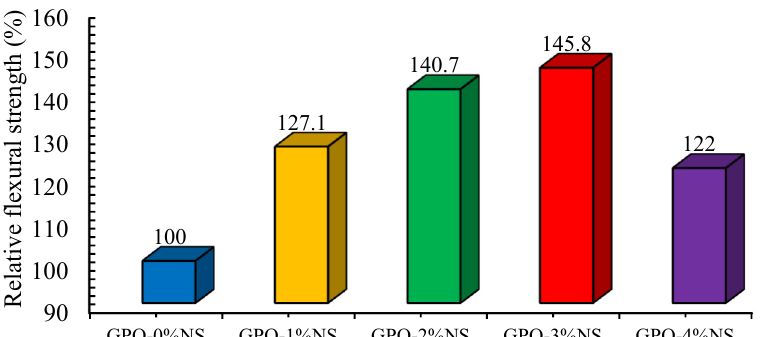
Figure 9. Comparison of the FLS of carbon-fiber-reinforced GPO composite pastes with different amounts of NS.